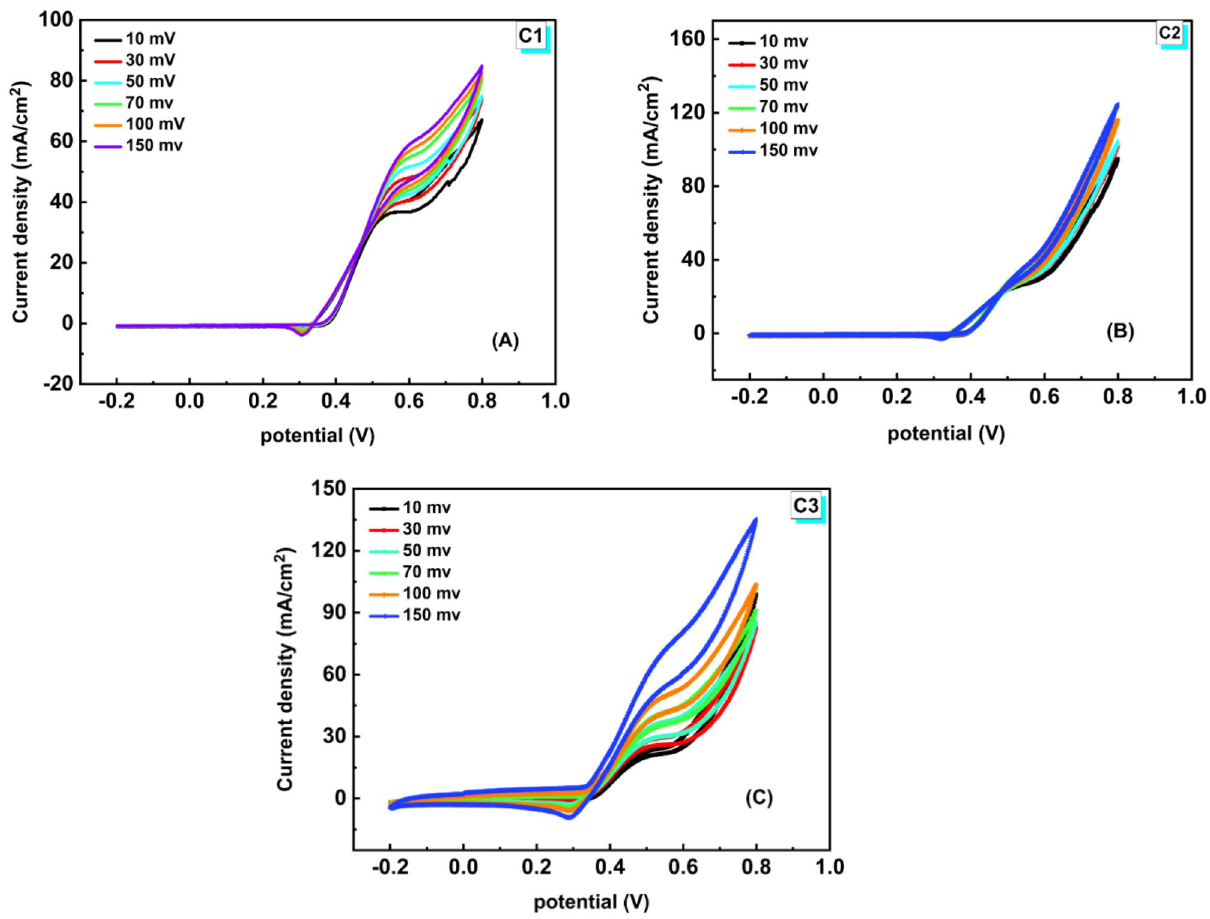
Figure 9. CVs of the investigated NFs (C1, C2, & C3) in the solution of 1.0 M KOH containing 2.0 M methanol at various SRs (10–150 mV/s).